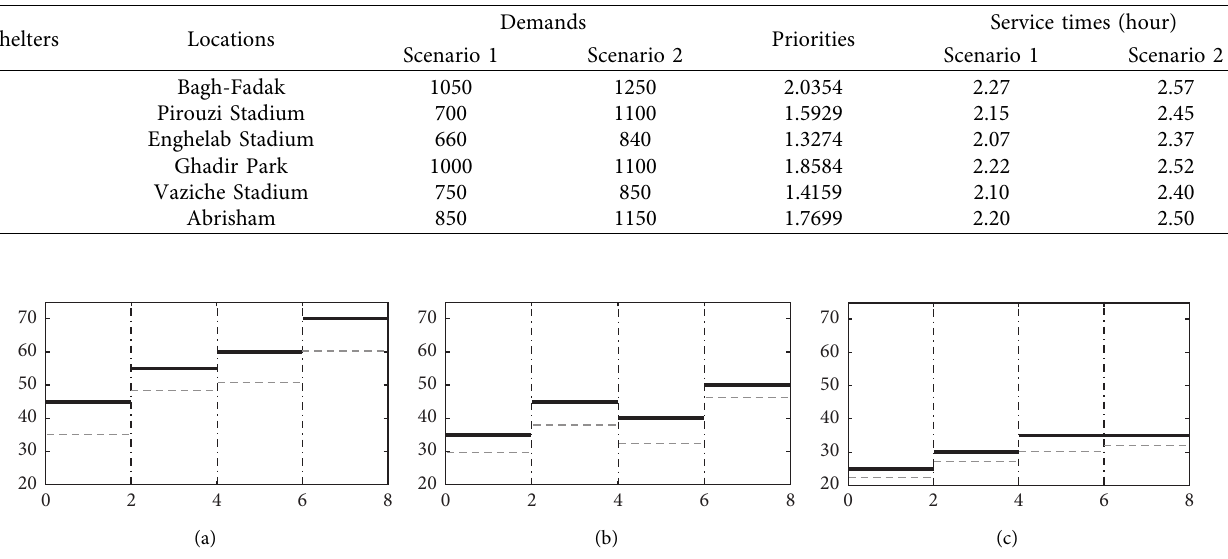
Table 7: Information regarding the main shelters in the network.